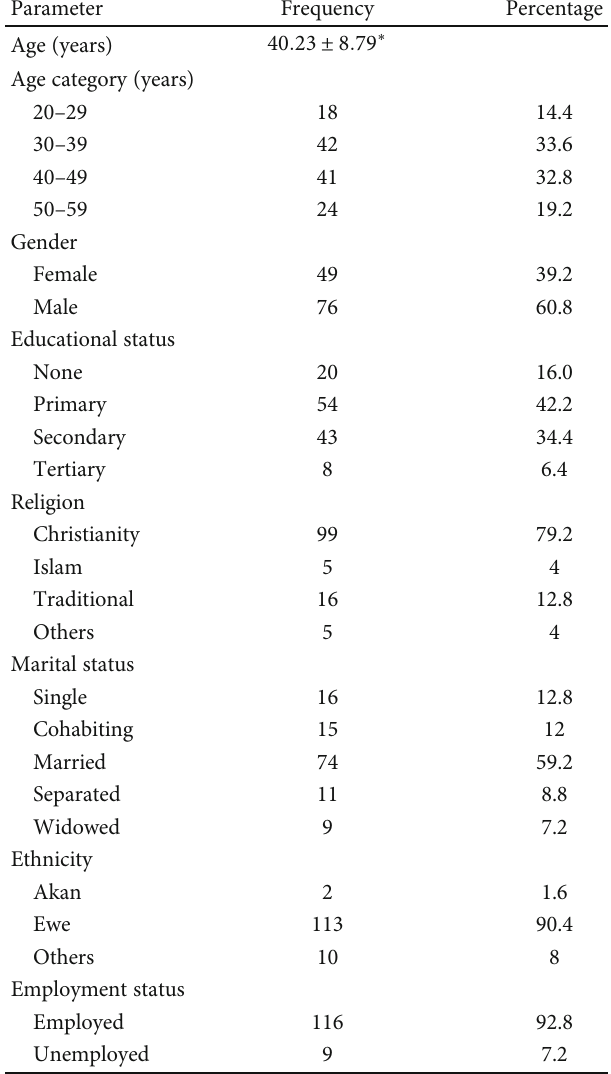
Table 1: Demographic characteristics of the study